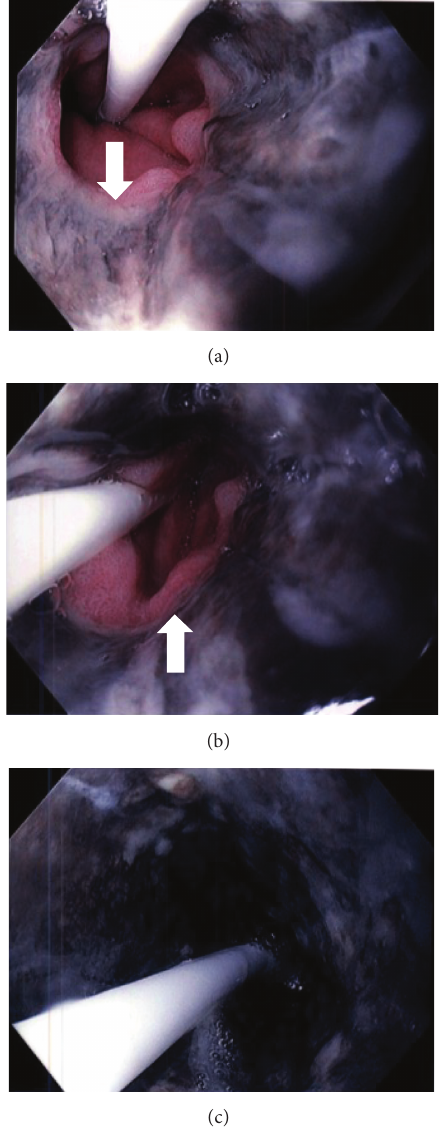
Figure 2: Images demonstrate circumferential esophageal necrosis extending from the mid esophagus (LL) to the distal esophagus with cleardemarcationatthegastroesophagealjunction(ULandURwith arrow). A transesophageal pressure catheter is seen in the images with distal end in the